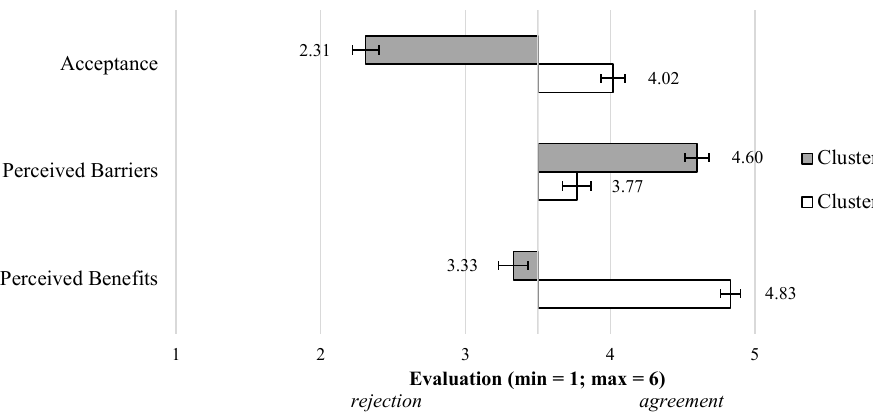
Figure 9. Cluster-specific acceptance of video-based AAL technology (n = 161).